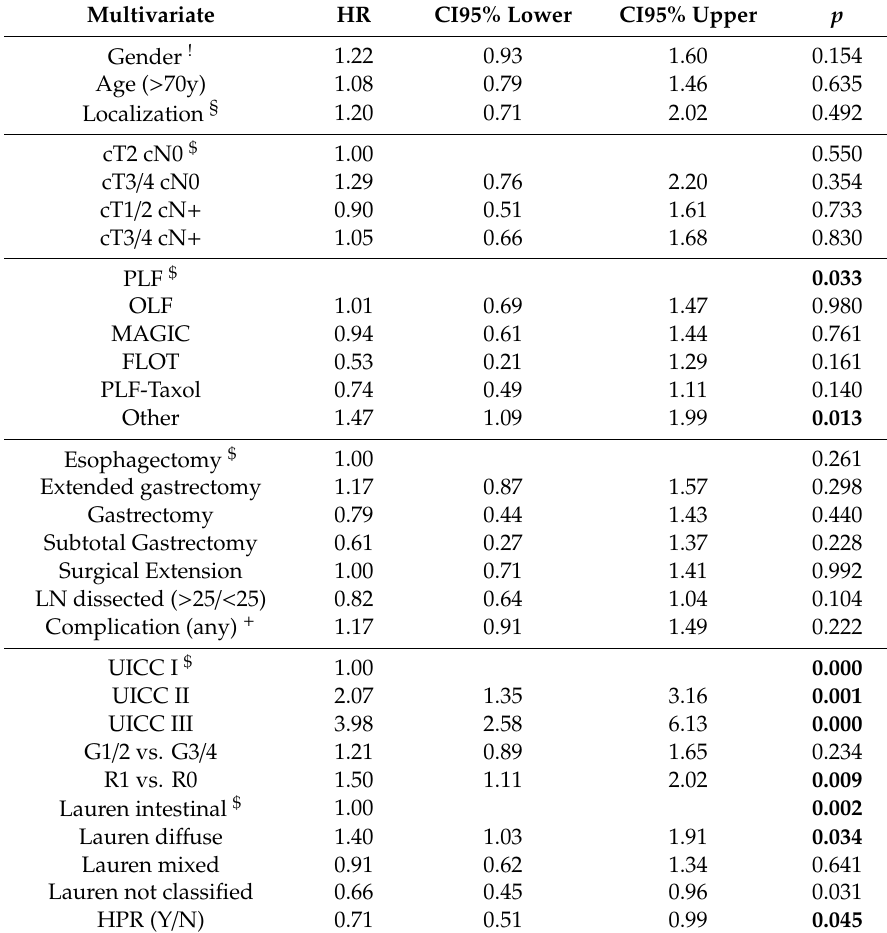
Table 3. Multivariate analysis of predictors for overall